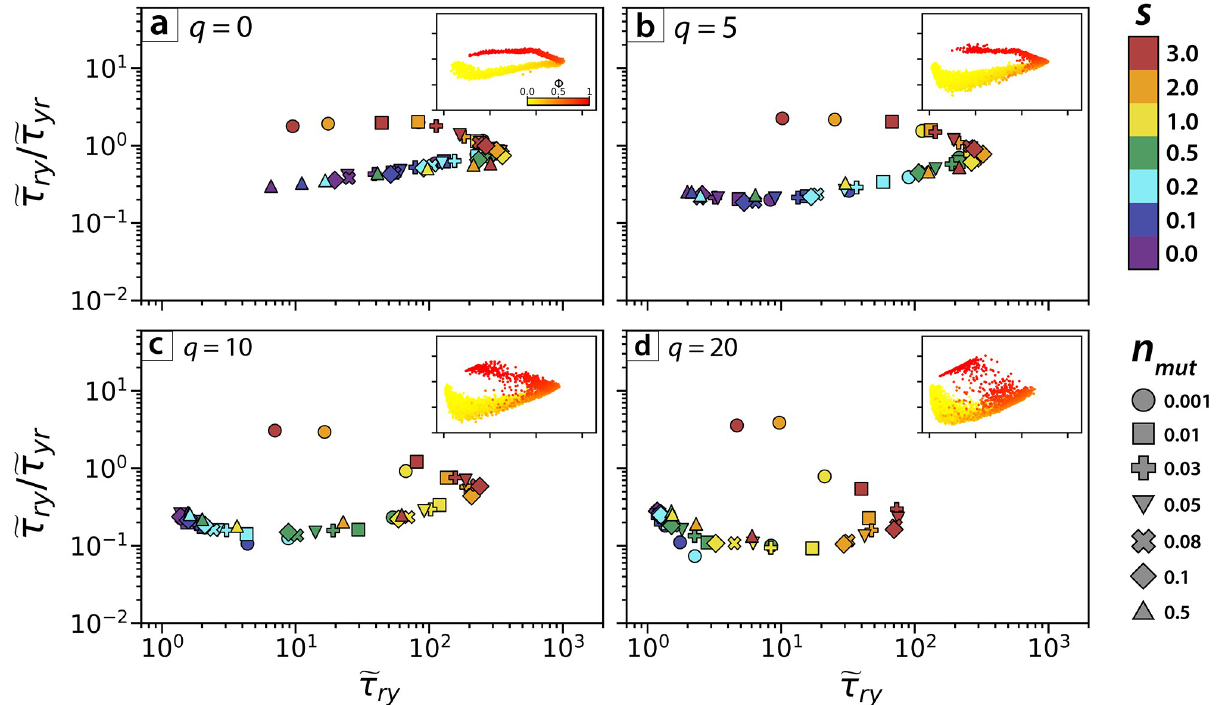
Fig 4. Analysis of simulated sub-clonal mixing patterns for varying sub-clonal dynamics. Mean CMFPT values for simulated sub-clonal mixing patterns in the phase space ( ~ t , ~ t = ~ t ), with points coloured according to values of model parameter s and point shape depending on parameter n mut . ry ry yr Data within each panel represent simulations for all possible combinations of s and n where s 2 {0, 0.1, 0.2, 0.5, 1, 2, 3} and n 2 {0.001, 0.01, 0.03, mut mut 0.05, 0.08, 0.1, 0.5} (approximately 100 simulated patterns for each parameter combination). Inset plots contain the same data as in the main panels, but show individual data points (one per pattern, n � 100 patterns per s and n combination) with point colour corresponding to the class ratio, ϕ . mut Images are separated depending on their pushing value q = 0 (a) , q = 5 (b) , q = 10 (c) and q = 20 (d) .